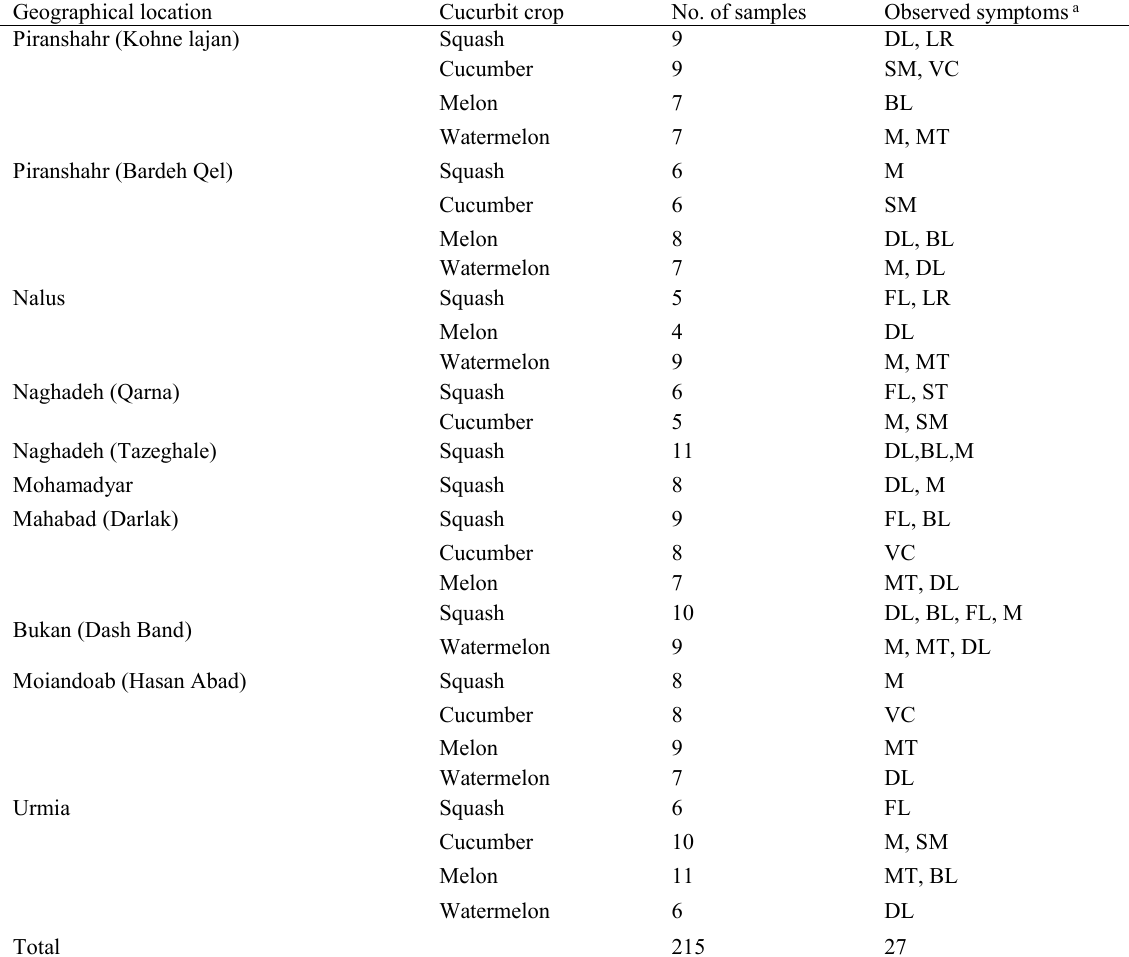
Table 1. Location and the number of collected samples. Geographical location Cucurbit crop No. of samples